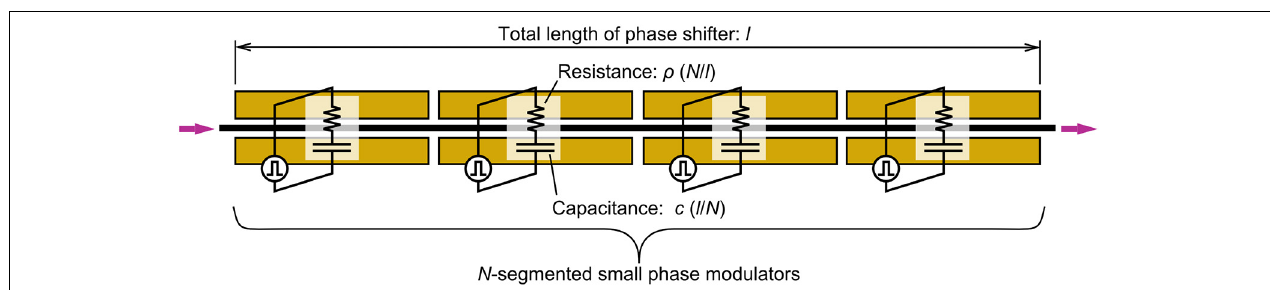
FIGURE 3 | Driving configuration of phase shifter for high-speed operation. Phase shifter is divided into N -small phase shifters. Each phase shifter is considered as simple RC lumped circuit and operated by signal source with suitable signal delay between them.